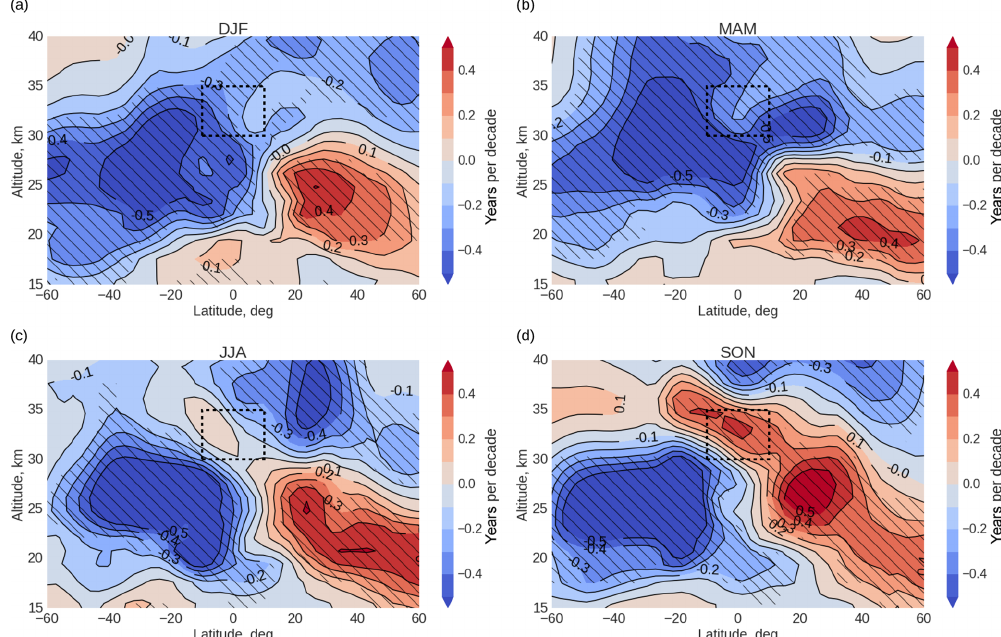
Figure 9. Latitude–altitude distribution of AoA changes (yearsdecade − 1 ) from MLR model based on the TOMCAT CNTL simulation during January 2004–April 2012 for (a) DJF, (b) MAM, (c) JJA, (d) SON: latitude range from 60 ◦ S to 60 ◦ N, altitude range from 15 to 40km. Hatched areas show changes significant at the 2 σ level. The dashed rectangle indicates the region of the tropical mid-stratosphere investigated in this paper.